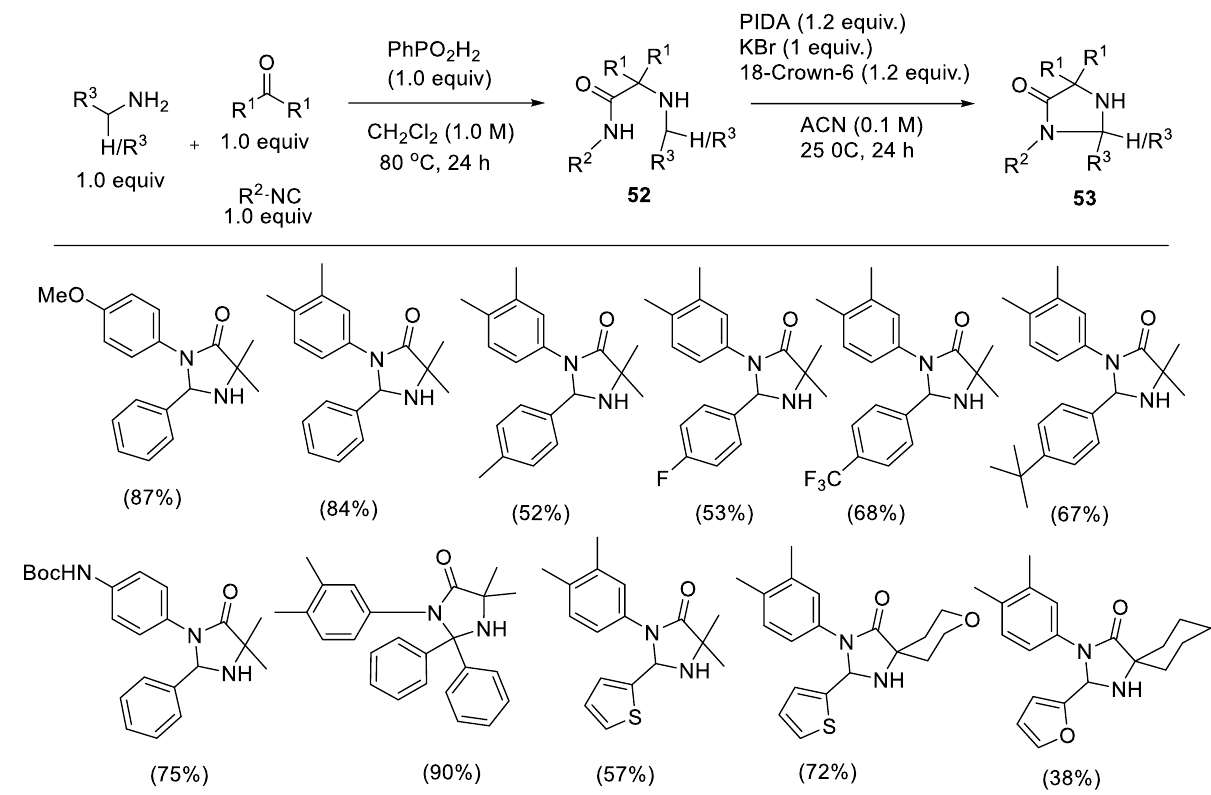
Scheme 9. PIDA-mediated synthesis of substituted